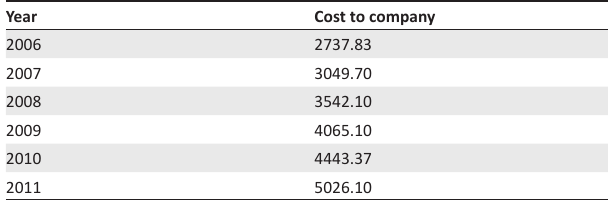
TABLE 4: Cost to company mean (R’000).